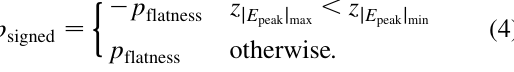
TABLE III. Injector optimization independent variables and ranges